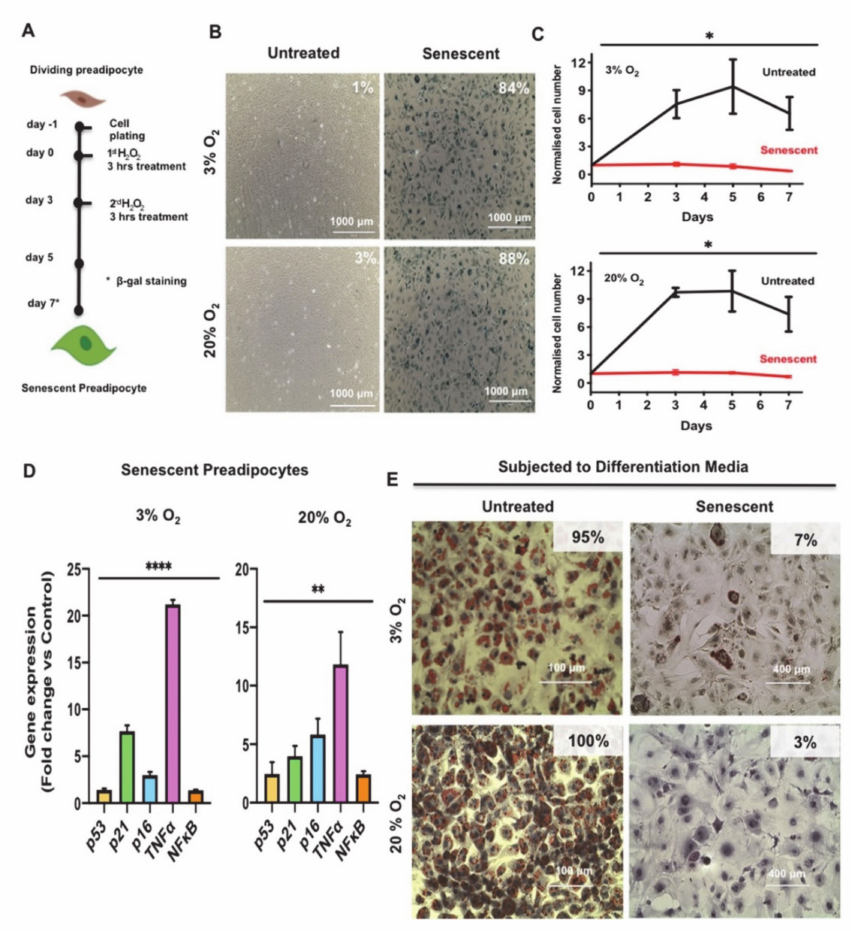
Figure 1. Induction of premature senescence in 3T3-L1 preadipocytes with H 2 O 2 impairs adipogene- sis. ( A ) Schematic representation of the H 2 O 2 treatment protocol to induce premature senescence in 3T3-L1 preadipocytes. ( B ) Senescence-associated beta-galactosidase (SA- β -gal) staining of prolif- erating (untreated) or senescent preadipocytes grown at 3% O 2 or 20% O 2 as indicated. SA- β -gal positive cells were quantified from four different fields and represented as a percentage within the images. Scale bar, 1000 µ m. ( C ) Growth curve analysis of 3T3-L1 preadipocytes subjected to the H 2 O 2 treatment protocol as in A compared to control untreated cells. The number of senescent cells and untreated cells were counted on different day and represented as a fold-increase over the number of seeded preadipocytes on Day-1. Results are presented as means ± standard error of the mean (SEM) of three independent experiments. ( D ) Gene expression analysis for relevant markers of senescence and inflammation. Gene expression results (fold change vs. control) of each indicated marker are presented as means ± SEM of three independent experiments. ( E ) Oil Red O and hematoxylin staining images of untreated or senescent preadipocytes (Day 7) maintained at either 3% O 2 or 20% O 2 condition subjected to adipocyte differentiation protocol. Scale bars: 100 µ m and 400 µ m. Statistically significant difference: * p ≤ 0.05, ** p ≤ 0.01, **** p ≤ 0.0001 (Student’s